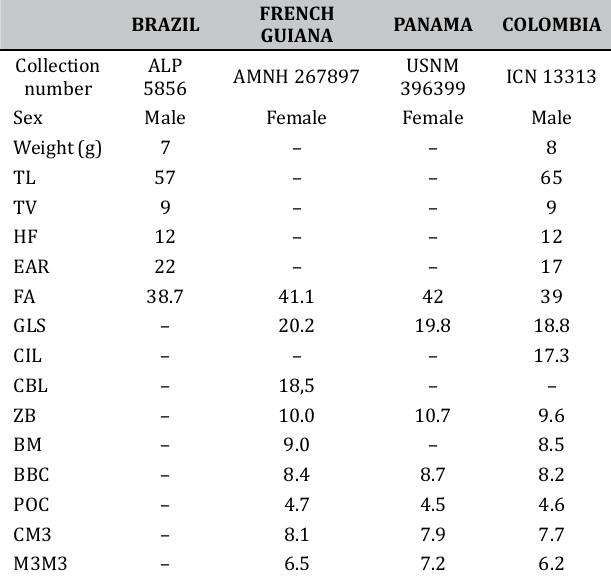
Glyphonycteris silvestris External and cranial measurements of the specimen of